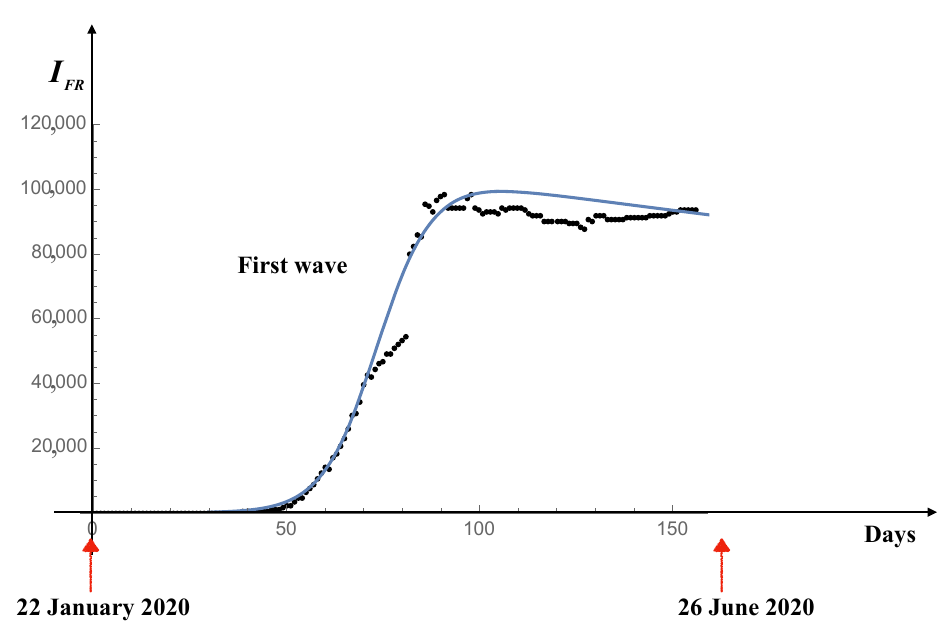
Figure 24. Comparison between theoretical predictions (blue line) and real data (black dots) for France during the first wave of Coronavirus. The values of the parameters are; ˜ α = 0.145 day − 1 , β = 0.5 day − 2 , K = 110,000, and t L = 53 days, respectively.